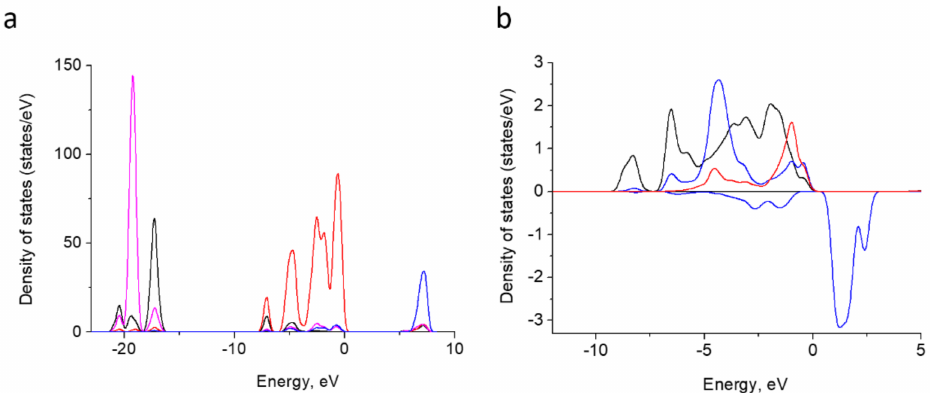
Figure 10. Atom-projected partial density of states curves for Ca-3p (magenta), Ca-3d blue, O-2s (black) and O-2p (red) in HA summed up overall relative atoms ( a ). Atom-projected PDOS curves for Fe-3d (blue; positive values for spin-up and negative ones for spin-down) and O-2p for adjacent oxygen atoms P-linked oxygen atoms (black) and H-vacancy bearing oxygen (red) ( b